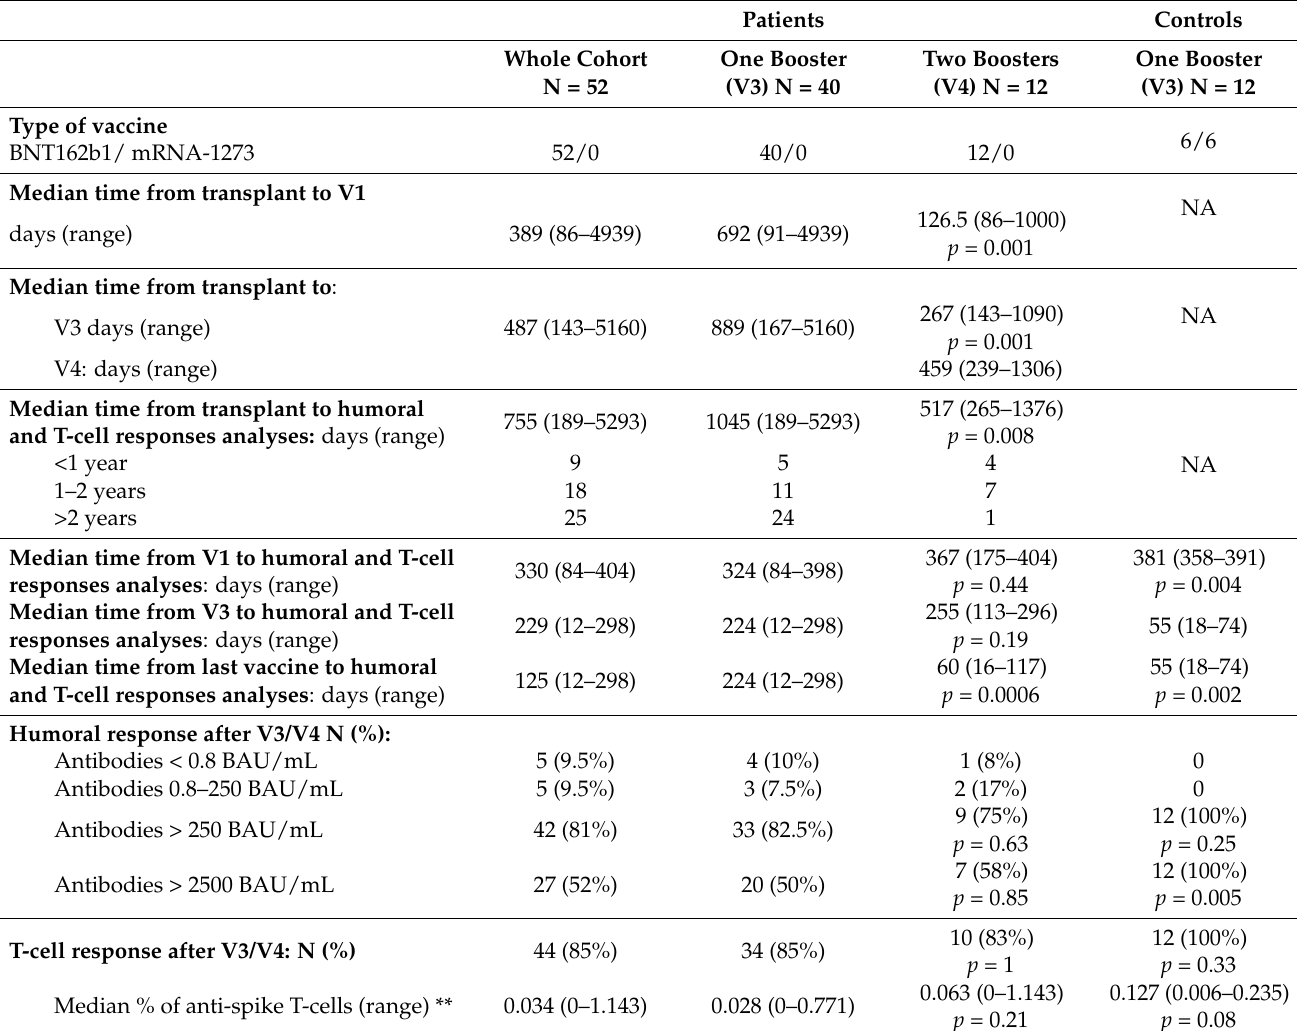
Table 2. Anti-SARS-CoV-2 vaccinations and anti-spike